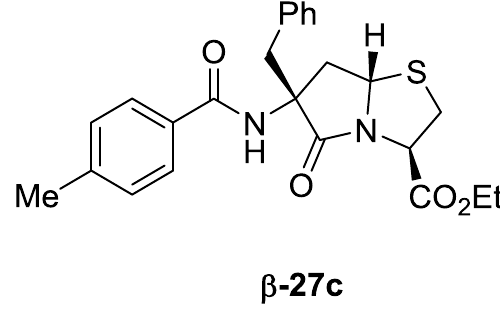
Scheme 7. Introduction of glycine residue into Scaffold 3 .